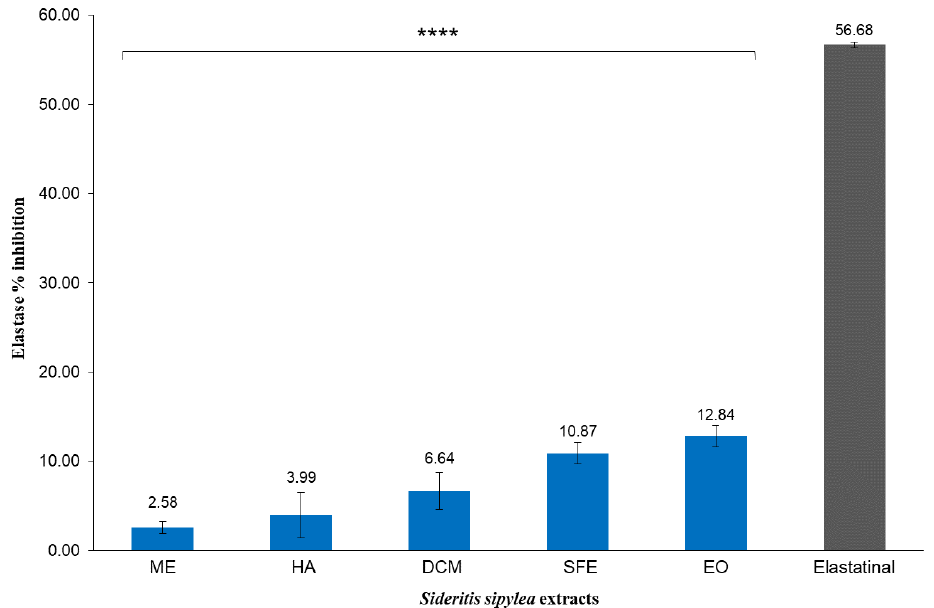
Figure 5. Elastase inhibitory effect of the methanol (ME), water/methanol (HA), dichloromethane (DCM), and supercritical fluid (SFE) extracts, along with the essential oil (EO) of S sipylea at 0.5 µ g / mL. Values are mean of three replicate determinations ± standard error. Elastatinal was used as a positive control at 0.5 µ g / mL. Statistical analysis was performed by one-way ANOVA, and Dunnett’s test was employed to compare extracts with the positive control, with p < 0.0001 (****).